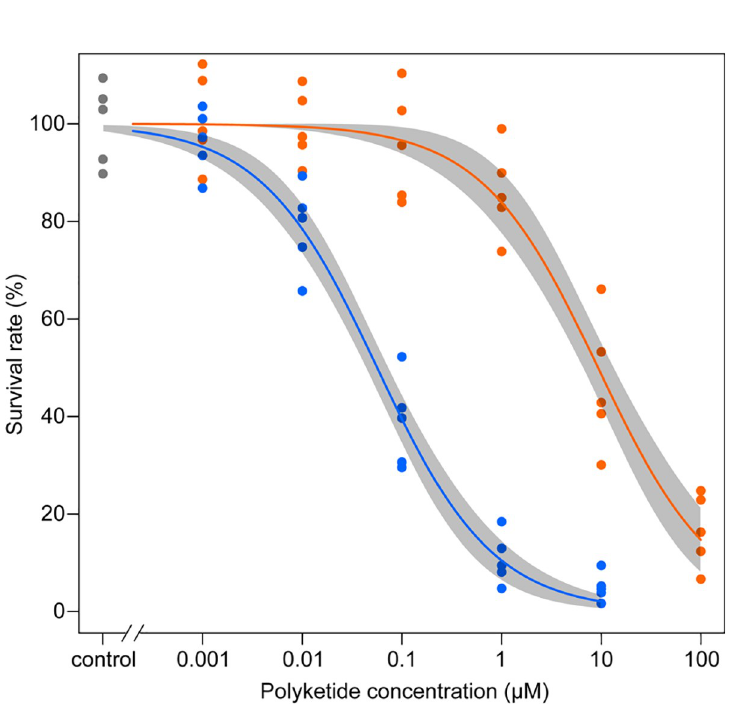
Fig 2. Effects of a 48-h exposure of Sf9 cells to diaphorin or pederin. Dose-response curves relating polyketide concentrations (x-axis) to Sf9 cell survival rates (y-axis). All data points (diaphorin: orange; pederin: blue; control: grey) of five repeated experiments are presented together with the lines corresponding to the fitted two-parameter log- logistic model analyzed with the statistical computing software R and its add-on package drc . Shaded bands represent 95% confidence intervals of the